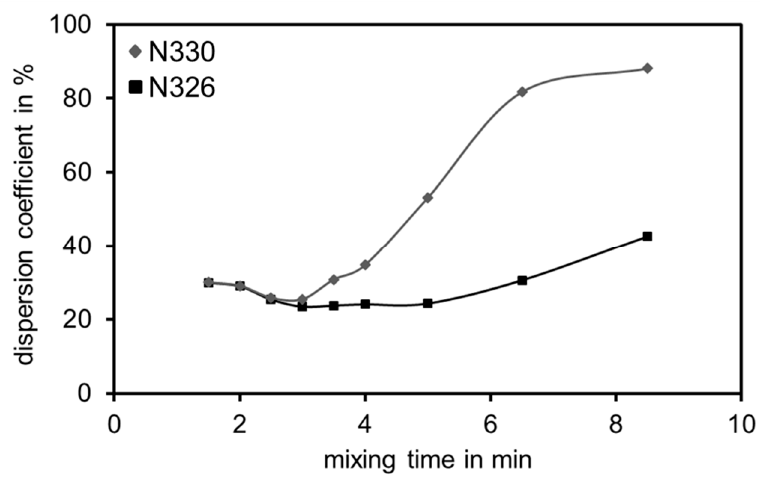
Figure 1. Influence of the carbon black structure of N330 ( ♦) and N326 ( ■ ) on the dispersion quality [18] .